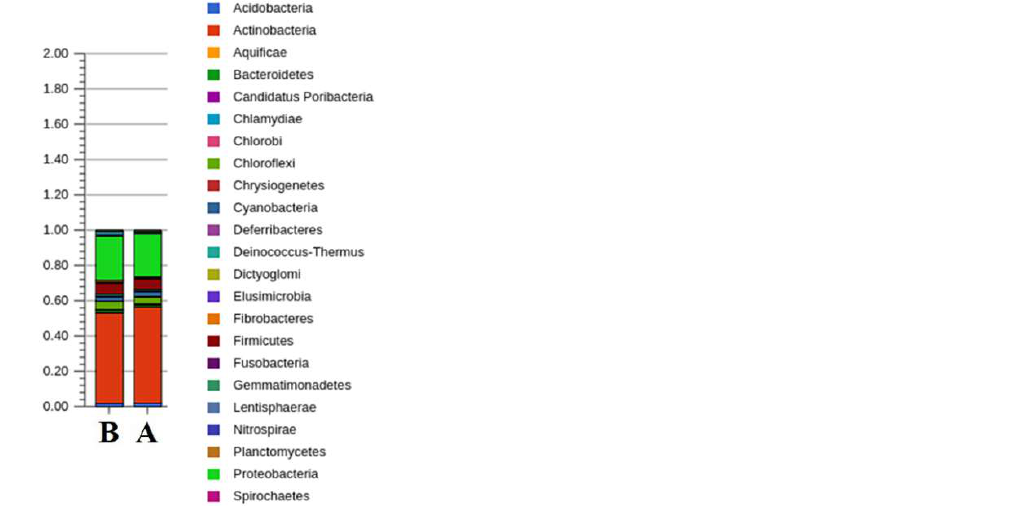
phyla based on the taxonomic affiliation of the annotated proteins within each metagenome.